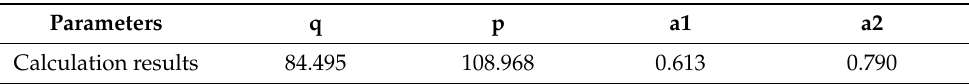
Table 18. Parameter calculation results.